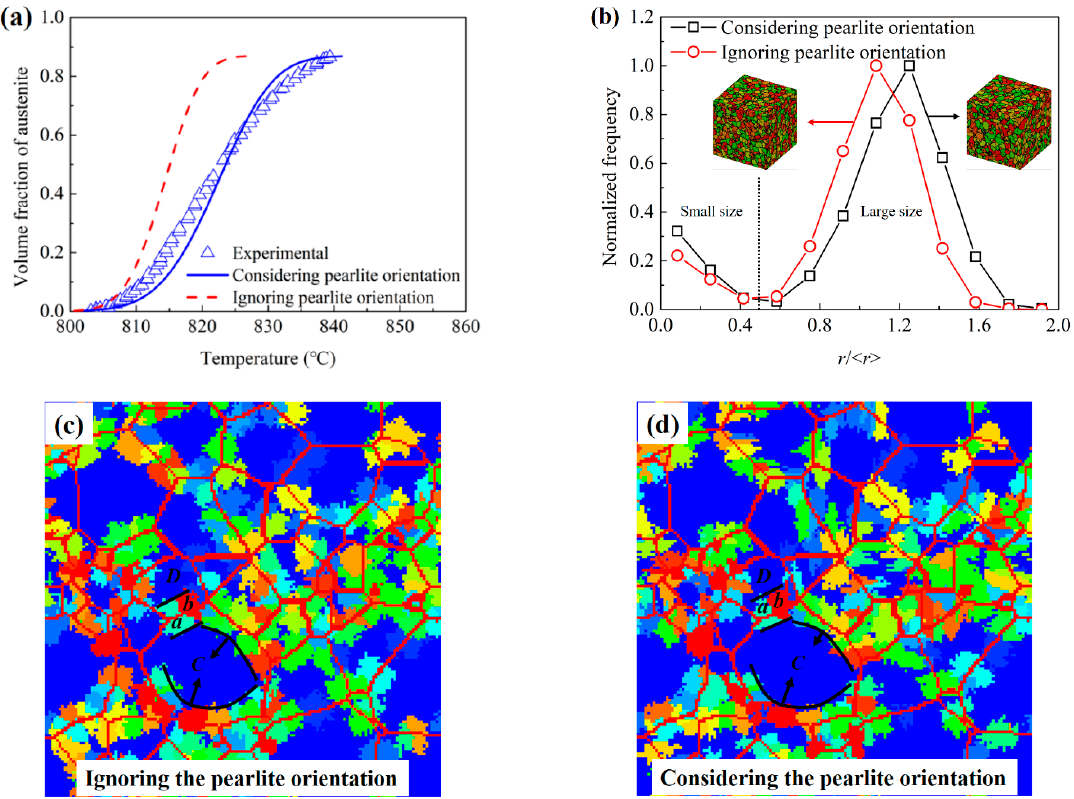
Figure 9. Simulation results for the models considering and ignoring the pearlite orientation. ( a ) Relationships between the austenite volume fraction and temperature; ( b ) grain size distribution; cross sections of the simulated microstructures for the models ignoring ( c ) and considering ( d ) the pearlite lamellae orientation.